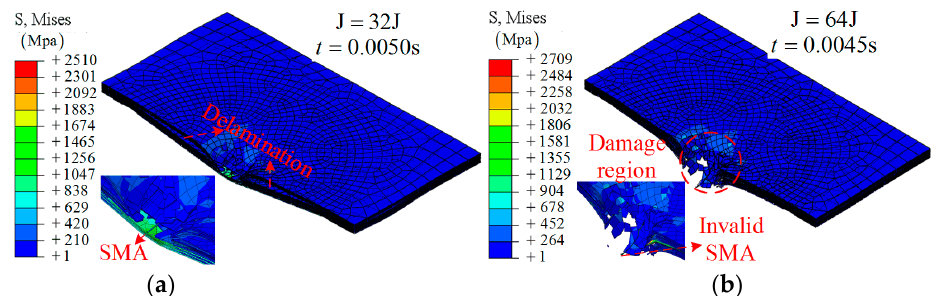
Figure 7. The simulation results on the SMA-reinforced composite laminates at different times: ( a ) group A3, t = 0.0050 s; ( b ) group A4, t = 0.0045 s.